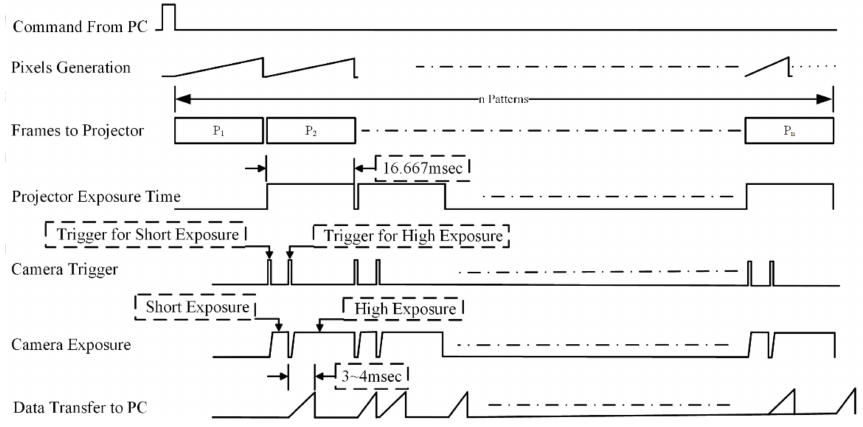
Figure 8. Timing diagram of multi-camera exposure in single projector exposure. Refer to the camera trigger signal for multiple capturing of low and high exposures within a single camera exposure setting.